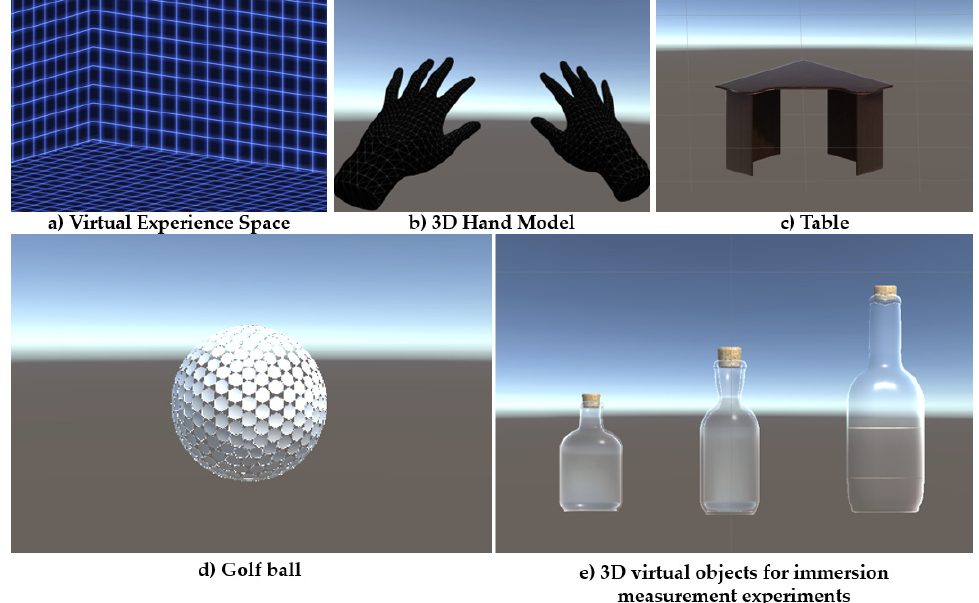
Figure 5. Virtual object weight recognition algorithm-based simulation content’s virtual environment. ( a ) A virtual experience space where the proposed algorithm is simulated, ( b ) a 3D hand model that receives and maps posture information from the user’s hand using the camera in Oculus Quest 2, ( c ) a table model that places virtual objects, ( d ) 3D Virtual Objects for Weight Recognition Experiments, and ( e ) 3D virtual objects for immersion measurement experiments.